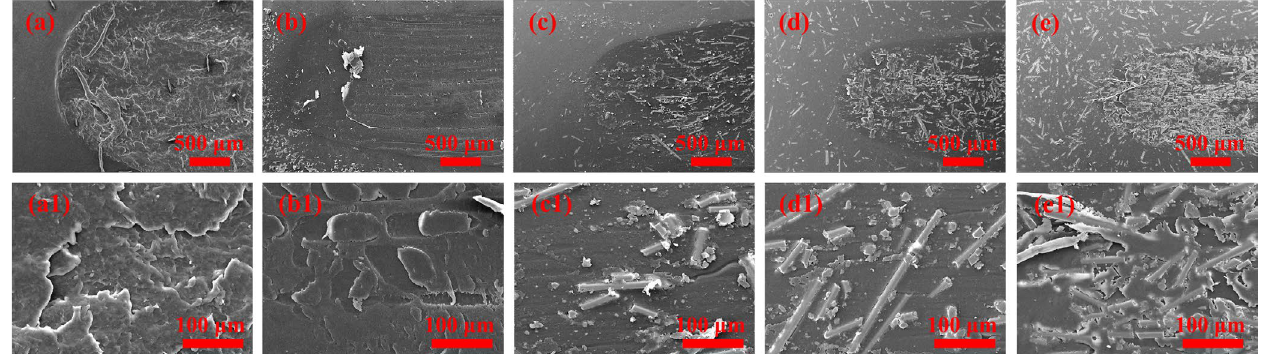
Figure 8. SEM micrographs of ( a ) neat PA 6, ( b ) PA 6/SEBS blend, ( c ) PA 6/SEBS/BF5, ( d ) PA 6/SEBS/BF10, and ( e ) PA 6/SEBS/BF20 ; ( a1 – e1 ) corresponding magnified SEM micrographs for neat PA 6 to PA 6/SEBS/BF20 .